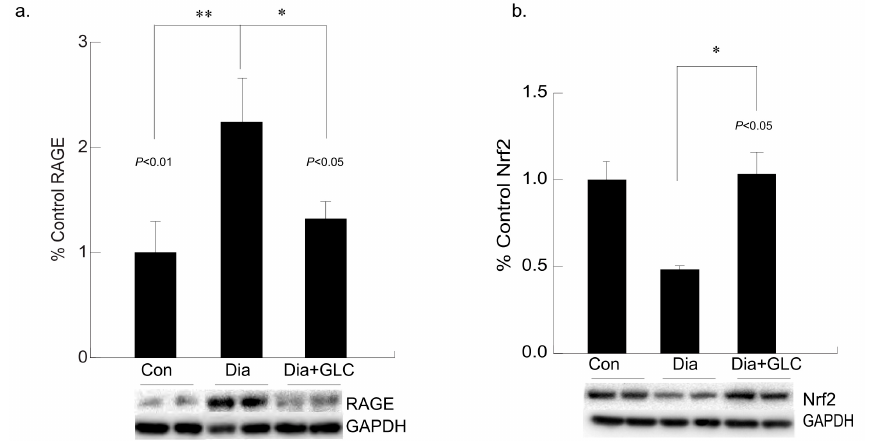
Figure 6. Long-term hyperglycemia exhibited altered levels of RAGE and antioxidant transcription factor, Nrf2 in ventricular cardiac tissue of diabetic rats, which were improved with GLC treatment. ( a ) Increased RAGE expression was observed in the ventricular cardiac tissue of ZDF diabetic rats compared to lean control animals (** p < 0.01) which was alleviated in the GLC treated diabetic animals (* p < 0.05). ( b ) Transcription factor Nrf2 expression in the cardiac tissues of the Type 2 diabetic animals was downregulated compared to the control animals. The ventricular cardiac tissue of ZDF animals treated with anti-inflammatory agent GLC for 4 weeks showed substantial improvement of Nrf2 expression (* p < 0.05).